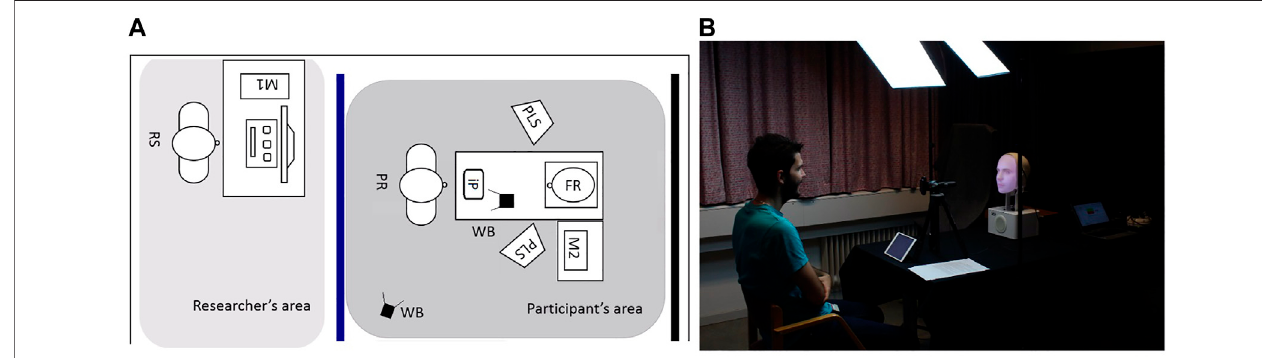
FIGURE 4 | (A) : the experimental setup. (B) : A participant in the participant